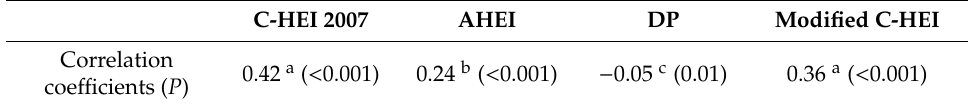
Table 6. Correlation coefficients between the cumulative number of nutrients 1 for which